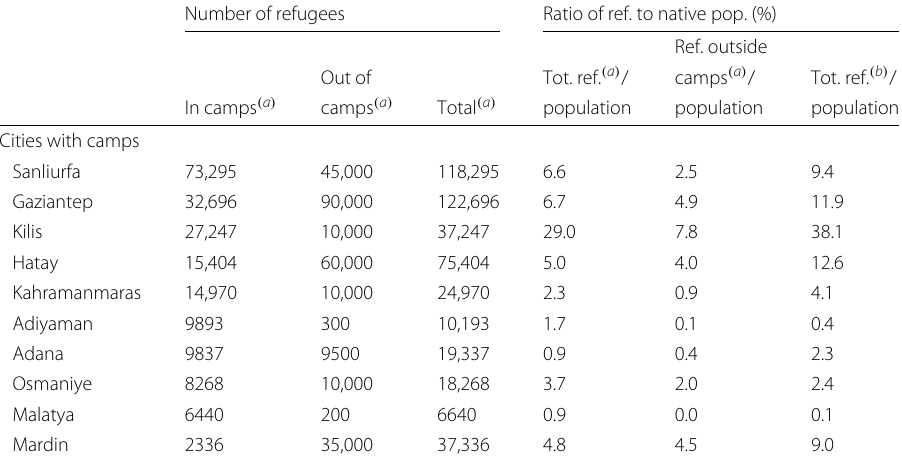
Table 1 The Geographical Distribution of Syrian Refugees in Turkey (2013) Number of refugees Ratio of ref. to native pop. (%) Ref. outside Out of Tot. ref. ( a ) / camps ( a ) / Tot. ref. ( b ) / In camps ( a ) camps ( a ) Total ( a ) population population population Cities with camps Sanliurfa 73,295 45,000 118,295 6.6 32,696